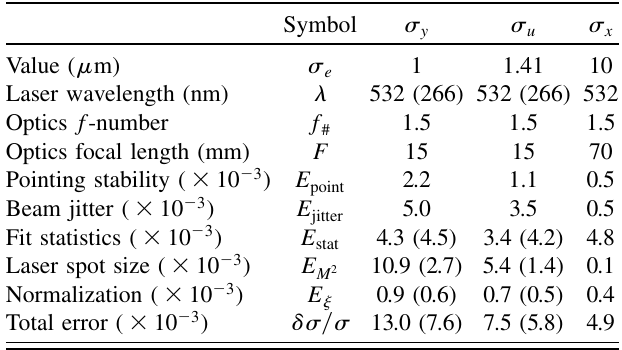
TABLE XI. Error terms for (cid:2) for an electron bunch whose ey (cid:1) 1 (cid:3) m and (cid:2) (cid:1) 10 (cid:3) m , giv- transverse dimensions are (cid:2) ey ex (cid:1) 1 : 41 (cid:3) m and (cid:2) (cid:1) 9 : 95 (cid:3) m . The values were ob- ing (cid:2) u v tained assuming the performance goals of Table X, laser (cid:1) 0 : 01 , (cid:2) (cid:1) 20 nm , (cid:10) (cid:1) 0 : 25 , The electron-bunch (cid:8) J BPM M 2 charge and laser power are assumed each to be known to 1% and the pointing jitter to 10%. The measurement statistical errors ’ 140 ). No subtraction of residual are for a full train (i.e. N scan dispersion has been made for these measurements; instead they are input into the global fit to extract the emittance and disper- sion terms together.